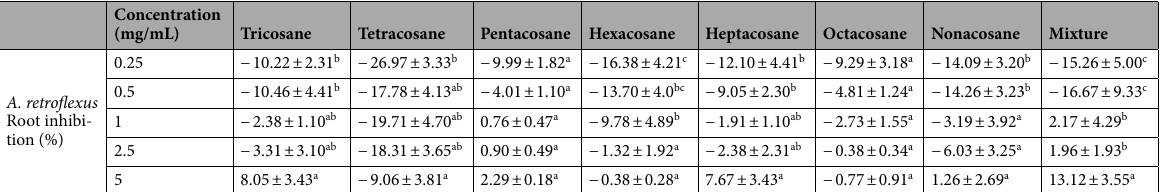
Table 2. Phytotoxic activity of alkanes on root growth of A. retroflexus . a ± Standard error ( n = 30). b Different letters represent a significant difference at p < 0.05 level according to Fisher’s LSD test.